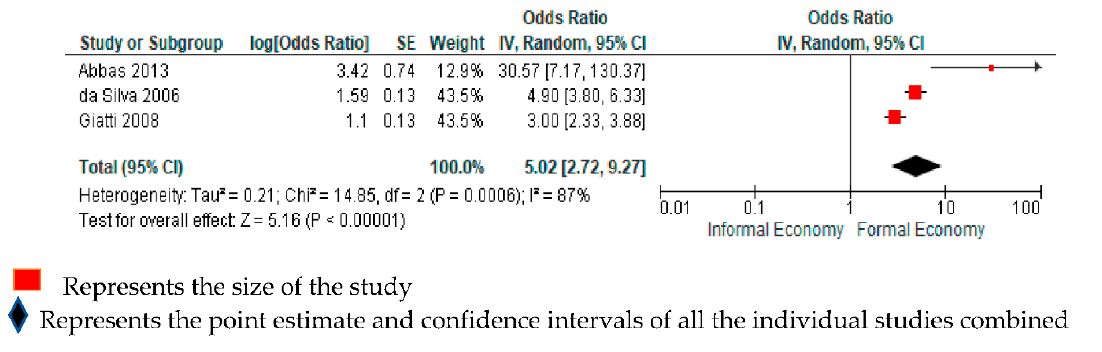
Figure 5. Forest plot for studies comparing depression in informal economy workers, compared with formal economy workers.